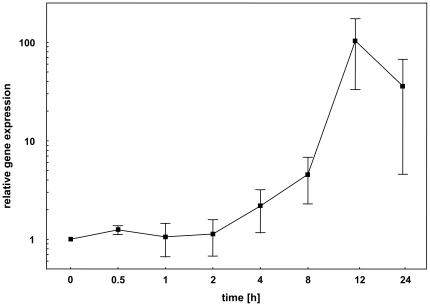

E. coli growth inside the host B. terrestris during the experiment.Temporal pattern of bacterial growth was measured, using relative gene expression of bacterial fadD, during the whole experiment from the starting point (0 hours) to end concentration after 24 hours post-injection. Relative bacterial growth was plotted on a logarithmic scale to show the real differences at each time point. At each time point the mean and s.e. of three individuals is shown.